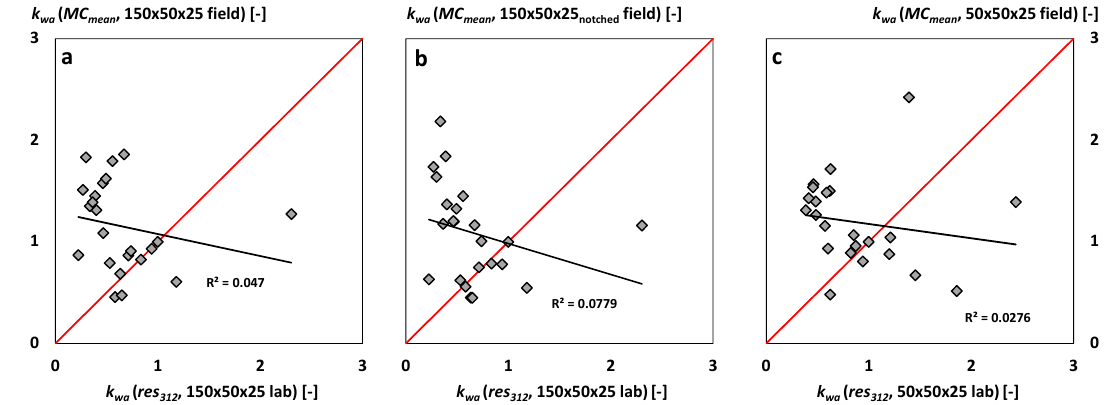
Figure 7. k wa factors based on MC mean (%) measured during outdoor exposure versus k wa factors of res 312 ( a-c ) in grams determined in submersion ( a , b ) and floating tests ( c ) according to [5].